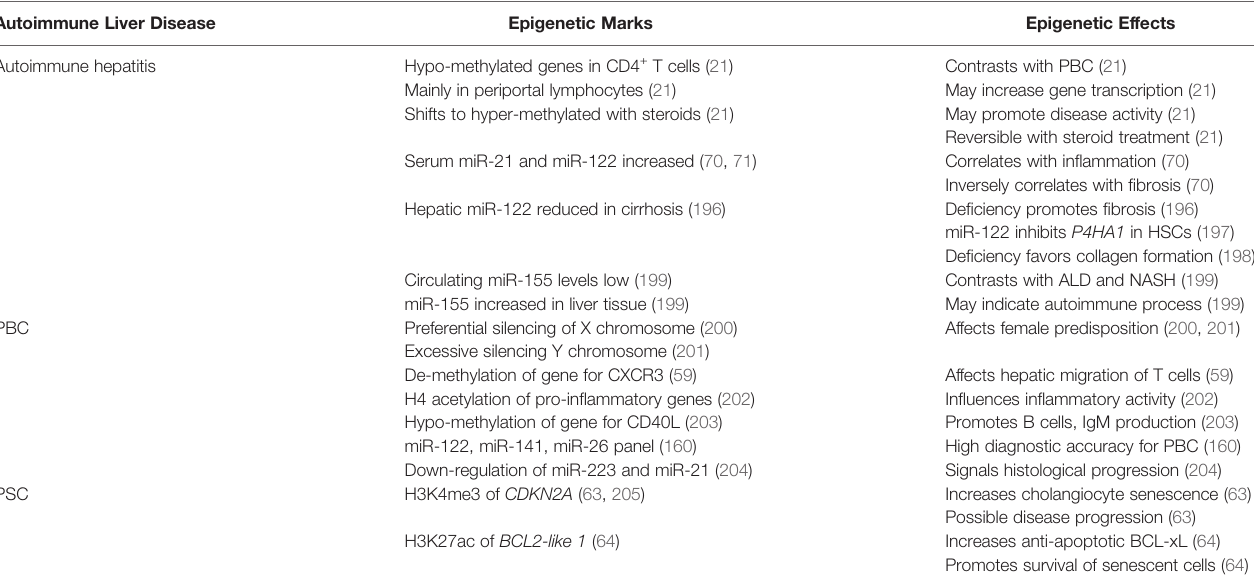
TABLE 3 | Epigenetic marks in autoimmune hepatitis and other autoimmune liver